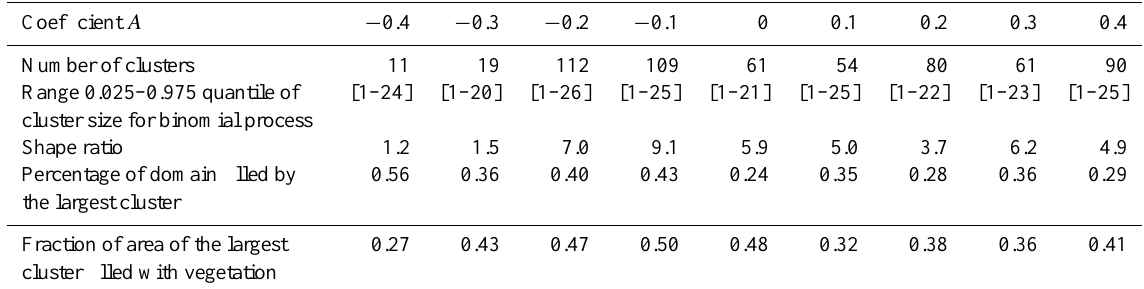
Table 4. Statistical analysis of the vegetation clusters for the fields of vegetation obtained with hydraulic conductivity functions, modified from the base conditions through Eq. (14). Coefficient